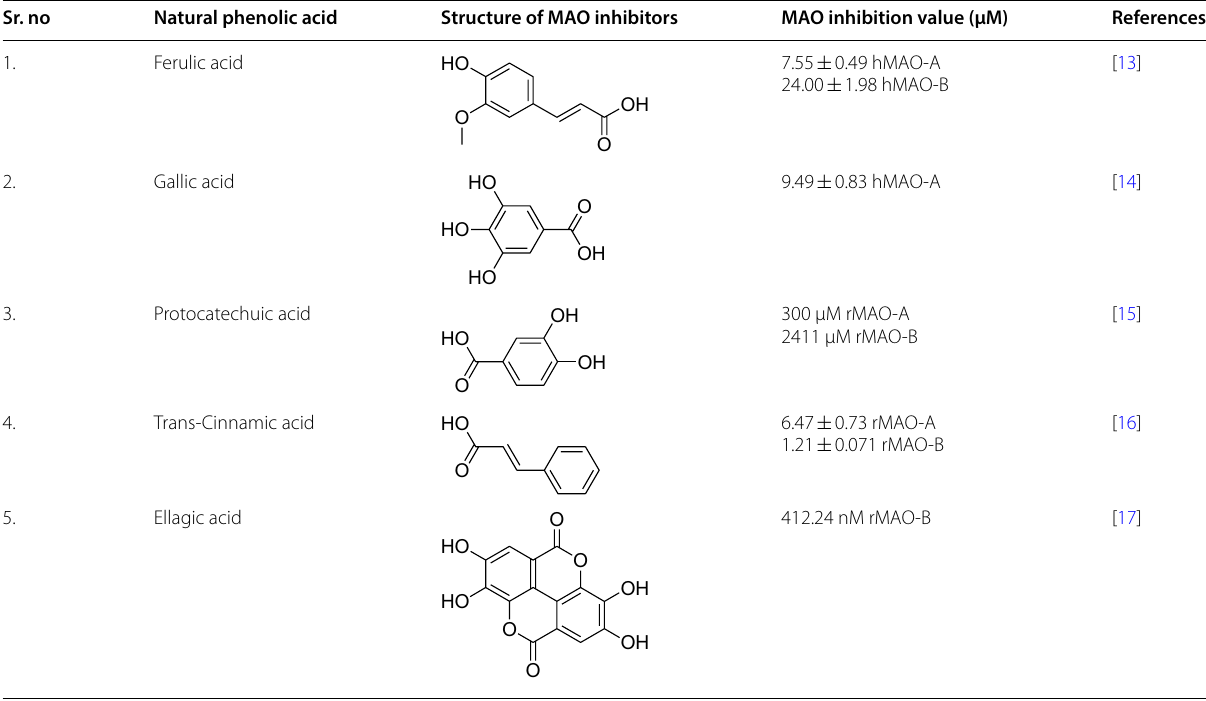
Table 1 MAO inhibition showed by different phenolic acids Sr. no Natural phenolic acid Structure of MAO